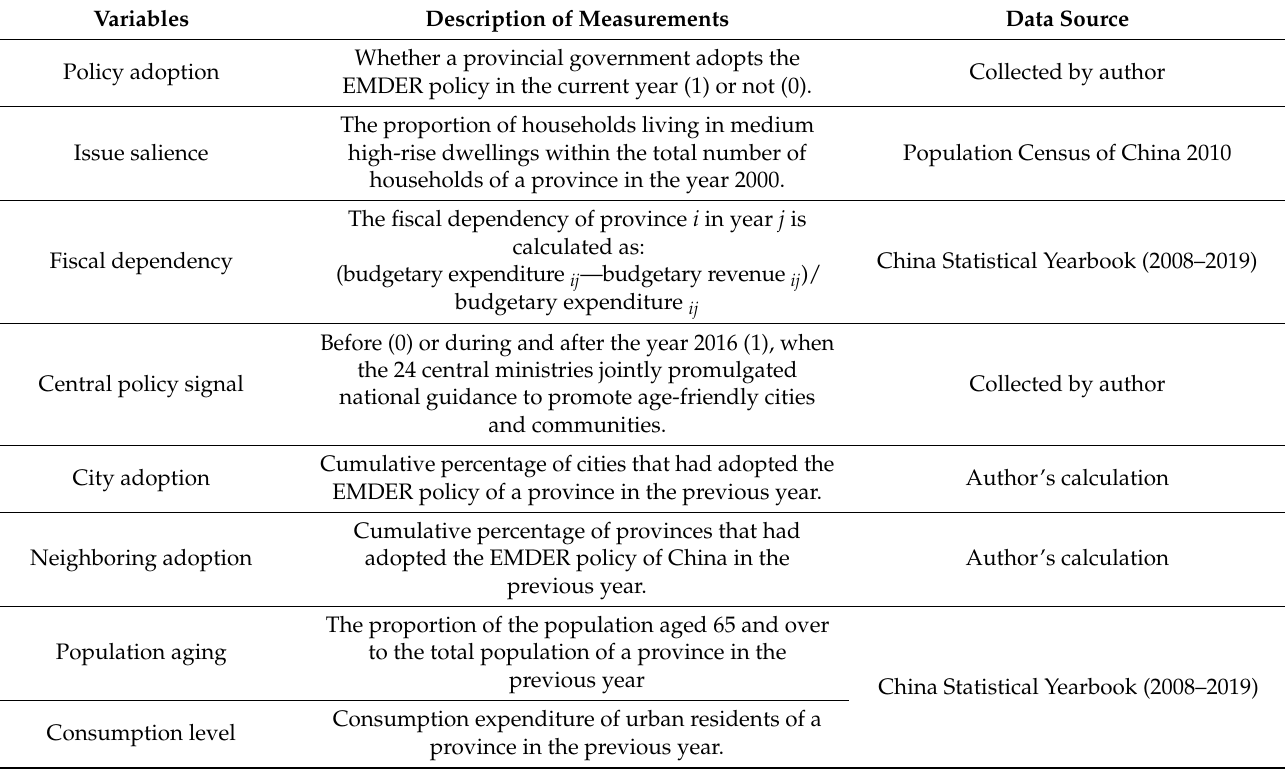
Table 1. Measurements of